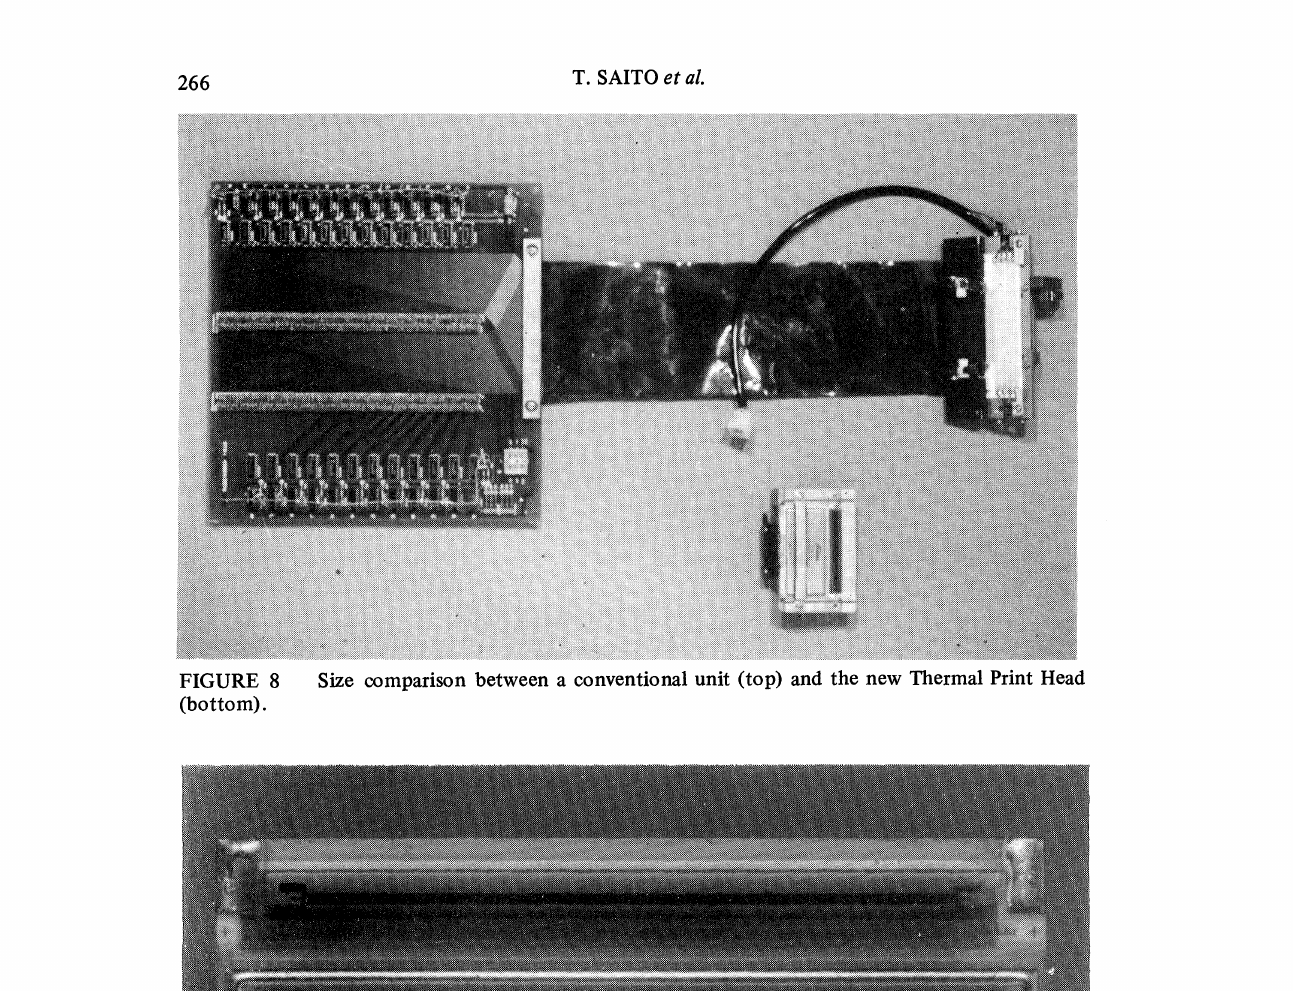
FIGURE 8 (bottom).